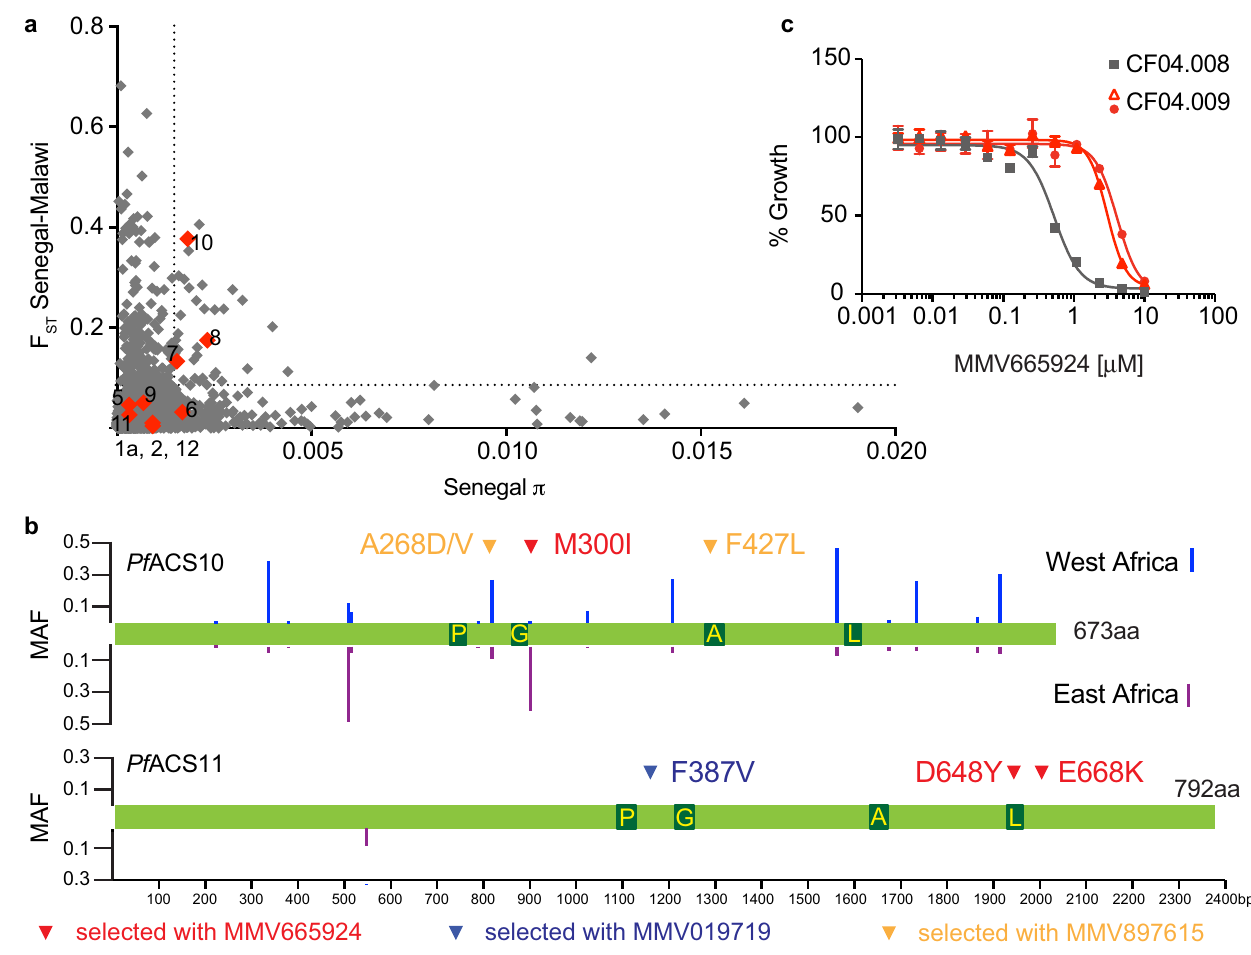
Fig. 3 | Naturally occurring variants in Pf ACS10 can confer resistance to MMV665924. EC 50 a Pairwise nucleotide diversity ( π ) and divergence ( F ST ) between Malawian and Senegalese populations for 4614 genes in P. falciparum . MembersoftheACSfamilyareindicatedinred.The95thpercentileisindicatedby a dotted line. Overall, pairwise π of Malawi and Senegal is highly correlated (two- tailed Pearson R 2 =0.94, p <1×10 − 15 ) and generally relatively low (median of 0.0003207and 0.0003214for Senegaland Malawi, respectively). b Distributionof non-synonymous single nucleotide polymorphism with global MAF>0.01 from globally diverse isolates (www.malariagen.net/pf3k). The length of the bars